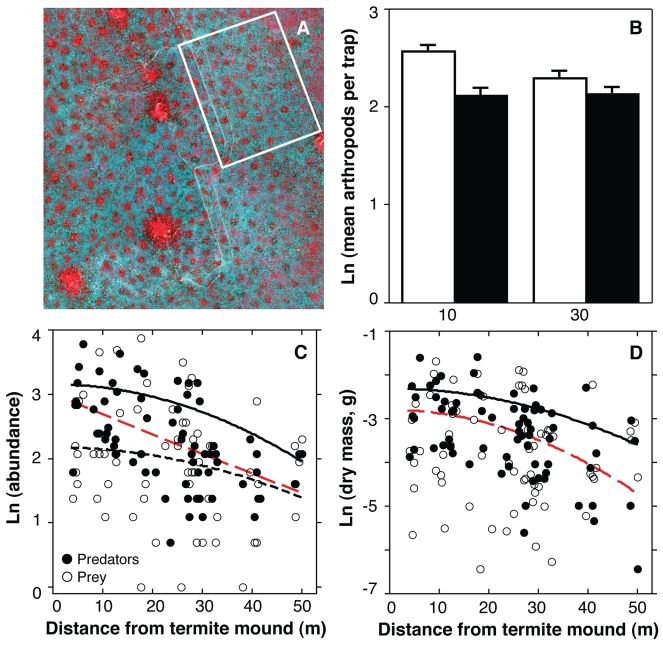
Patterns in arthropod communities.(A) Multispectral Quickbird satellite image (2.4 m resolution, here in false-color infrared) showing even spacing of termite mounds (small circular regions with red color indicative of high primary productivity; large red regions are abandoned cattle corrals). White rectangle encompasses the 0.36 km2 area mapped for analyses (see Figures 2B and 4). (B) Aerial-arthropod abundance. White bars represent sides of traps facing mounds (± SE), black bars the opposing sides (repeated-measures MANOVA: mound proximity F
1,33 = 9.5, p = 0.004; orientation F
1,33 = 49.0, p<0.0001; proximity × orientation F
1,33 = 10.9, p = 0.002). (C) Arboreal-arthropod abundance. Fitted curves are regressions against raw mound proximity (for predators only; red-dashed line) and square-transformed mound proximity (for prey only and for all arthropods combined; black-dotted and solid lines, respectively). The form of these curves and the following tests of significance for mound-proximity were determined from the best-fitting multiple regressions in Table S3 (all arthropods combined: F
1,61 = 22.6, p<0.0001; prey only: F
1,62 = 4.9, p = 0.03; predators only: F
1,62 = 49.3, p<0.0001). Omitting the 34 mantids, such that predators are represented by spiders only, does not change the results (r = −0.81, F
1,62 = 42.8, p<0.0001). (D) Arboreal-arthropod biomasses as functions of mound-proximity squared. Statistics and symbols as above (all arthropods: F
1,62 = 15.0, p = 0.0003; prey only [non-significant, no curve]: F
1,62 = 0.7, p = 0.4; predators only: F
1,62 = 26.5, p<0.0001; spiders only: r = −0.55, F
1,61 = 16.1, p = 0.0002).